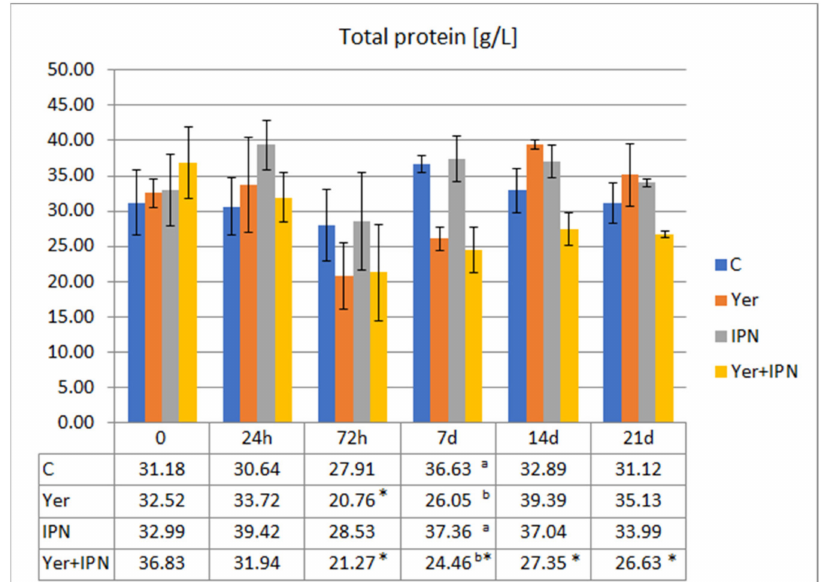
Figure 5. Mean values and standard deviation of total protein levels over the course of the first experimental infection. *—statistically significant differences compared to the day 0 values within a given group ( p ≤ 0.05); a, b —statistically significant differences between the groups on a given sampling day ( p ≤ 0.05).